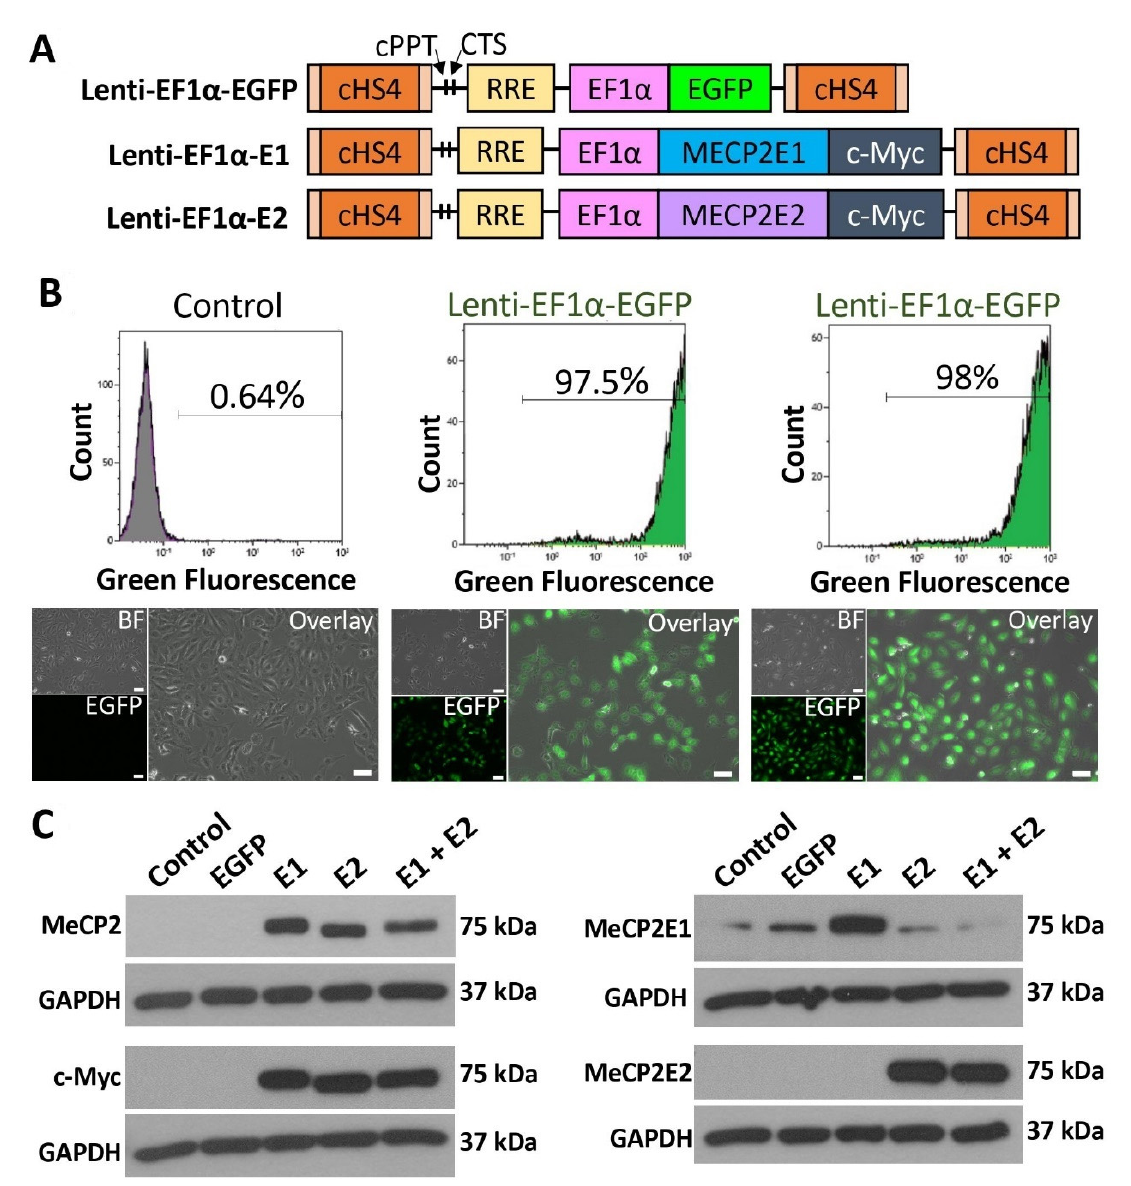
Figure 1. Establishment of MeCP2 isoform-specific overexpressing human Daoy brain cells using lentiviral vectors. ( A ) Schematics of lentiviral vectors used to express EGFP , MECP2E1, or MECP2E2 under the control of the EF1 α promoter. MeCP2 isoforms are tagged with a C-terminal c-Myc tag. cHS4: chicken β -globin locus hypersensitive site 4; cPPT: central poly purine tract; CTS: central terminal sequence; RRE: Rev-responsive element (Part A is adapted from Rastegar et al. 2009) [28]. ( B ) Flow cytometry analysis and fluorescence microscope images of non-transduced control and EGFP expressing cells. BF: bright field, scale bars represent 50 µ m. ( C ) Western blot analysis of total MeCP2, c-Myc tag, and MeCP2E1/E2 isoforms in non-transduced control Daoy cells, EGFP-transduced (EGFP), E1-transduced (E1), E2-transduced (E2), and E1 + E2-tranduced (E1 + E2)